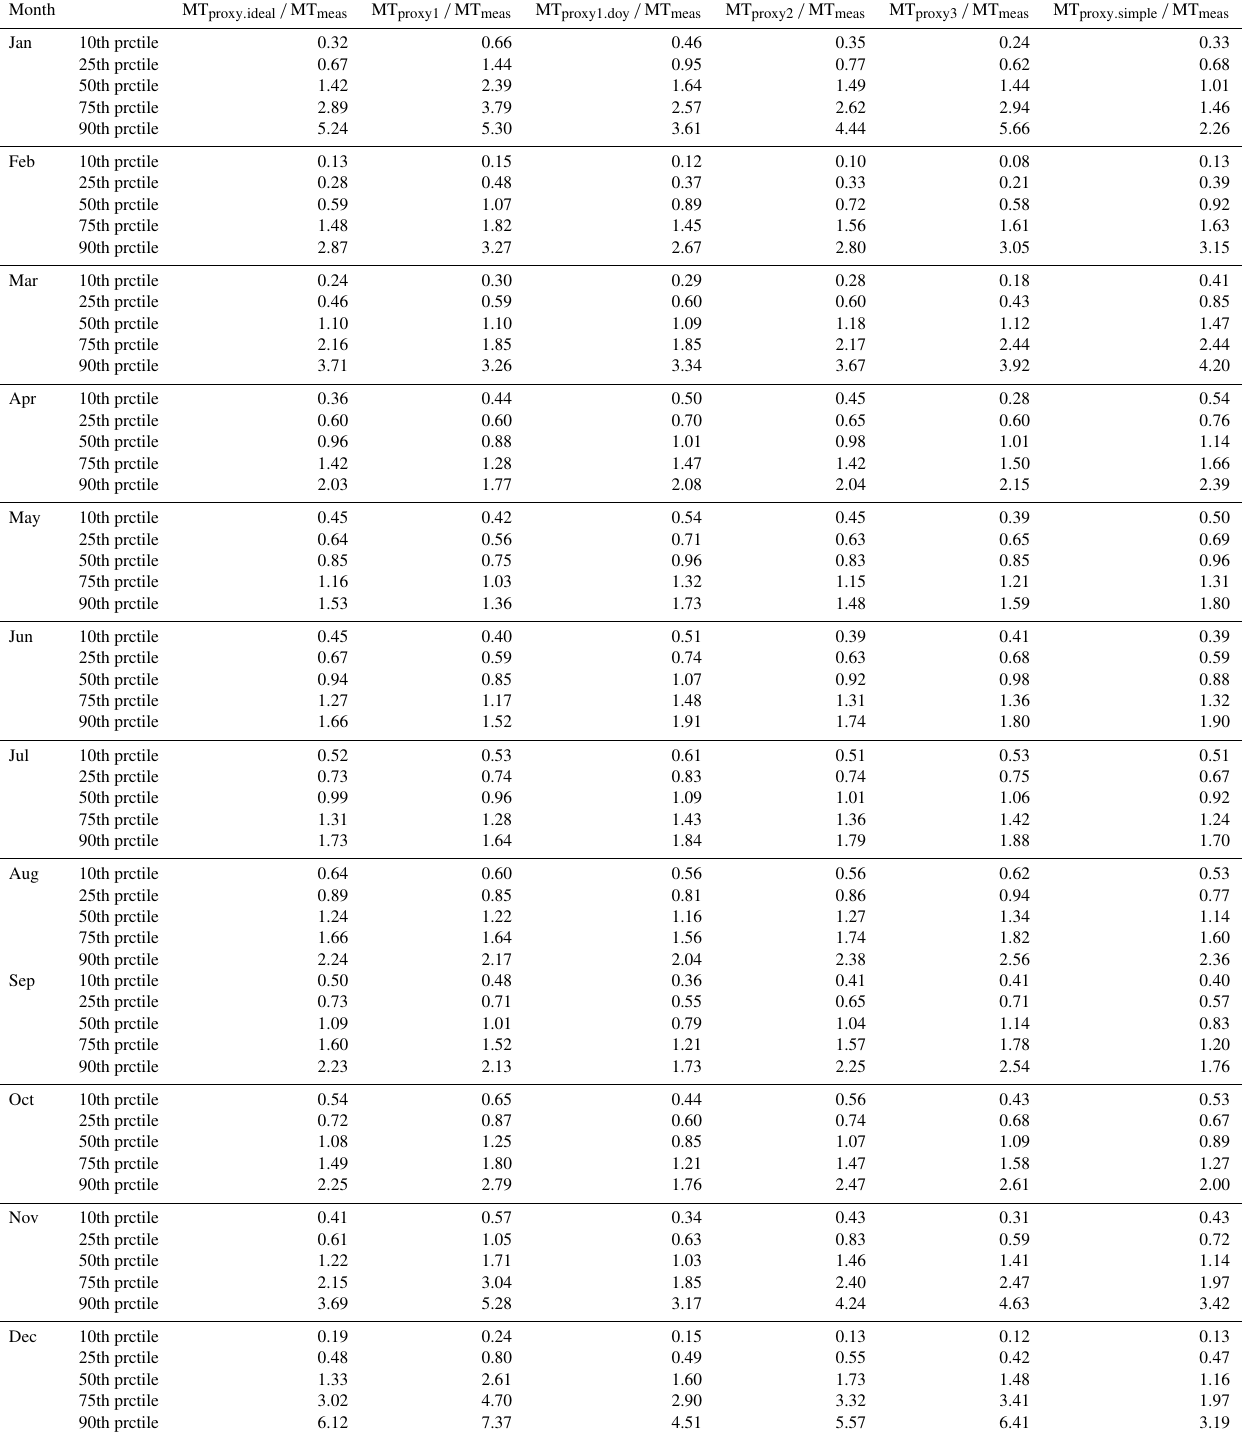
Table A2. The statistics of the ratio between the proxies and the measured monoterpene concentration in different months. The 10th, 25th, 50th, 75th and 90th percentiles (“prctile”) of the ratio are